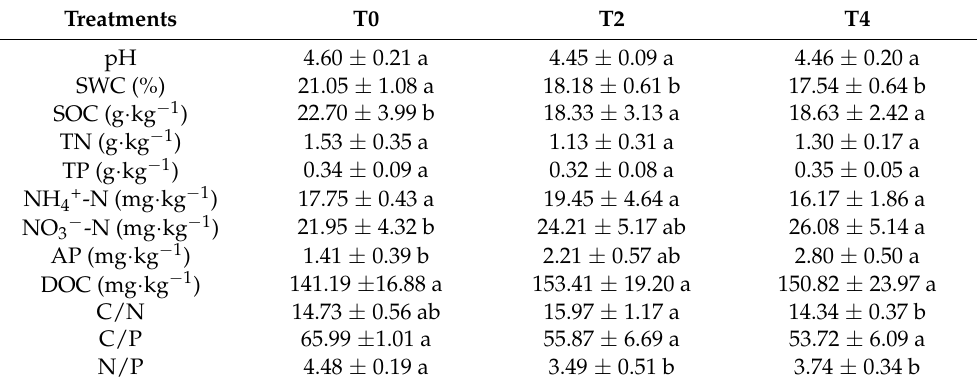
Table 1. Soil physical and chemical properties contents under different treatments.